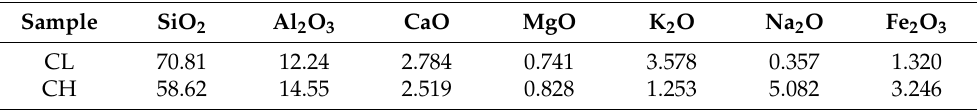
Table 1. Chemical compositions (%) of raw zeolite samples obtained from XRF analysis, presented as % w/w content of mineral